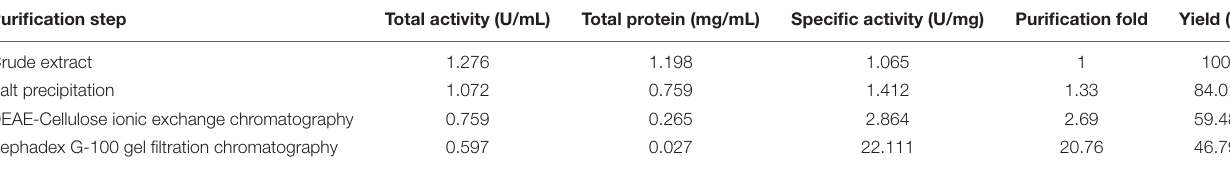
TABLE 1 | Summary of purification steps of laccase ThLacc-S from Trametes hirsuta . Purification